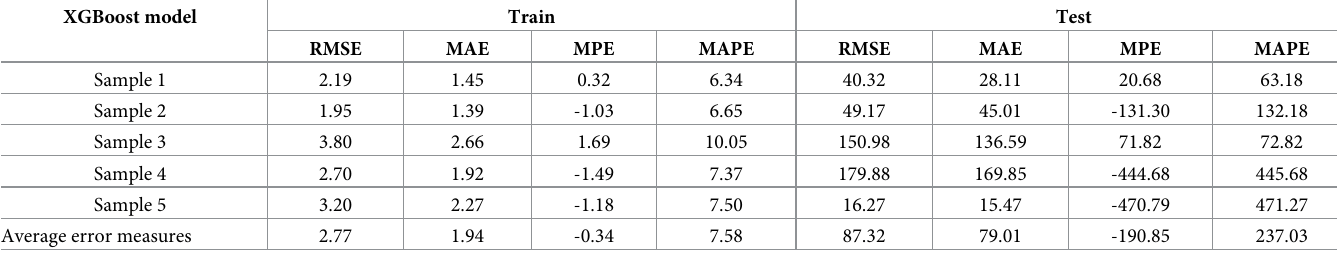
Table 5. Evaluation of parameters for the XGBoost models of different training and test sets for COVID-19 deaths. XGBoost model Train Test RMSE MAPE Sample